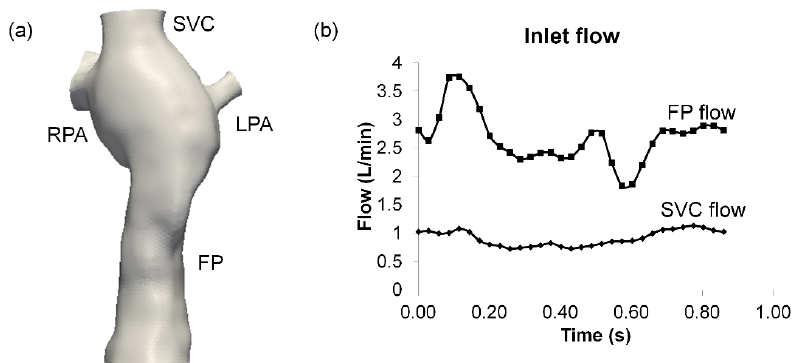
Figure 1. Reconstructed ( a ) 3D anatomy and ( b ) inlet flow waveforms. FP: Fontan pathway, SVC: superior vena cava, LPA/RPA: left/right pulmonary artery.